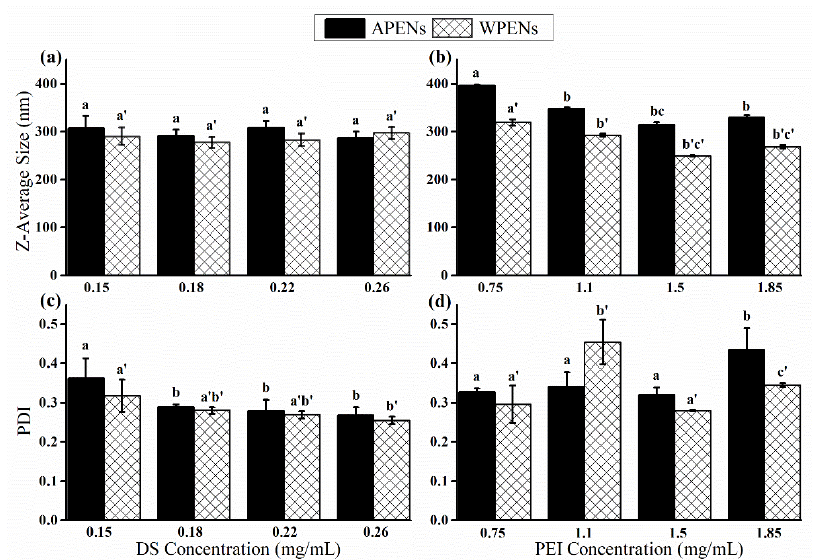
Figure 1. The effect of DS and PEI concentration on z-average size ( a and b ) and PDI ( c and d ) of the PENs. Different letters of a, b and c indicate significant differences between the z-average size and PDI of APENs at different concentrations of DS and PEI, but a’, b’ and c’ are related to significant differences in WPENs ( p value < 0.05).